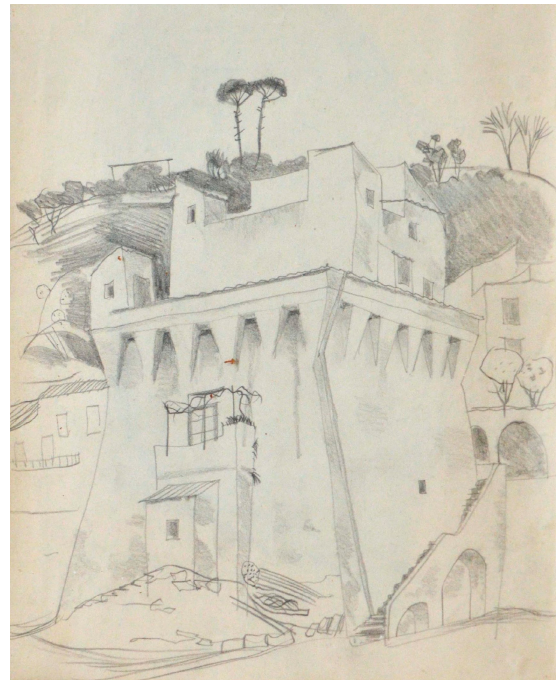
Figure 3. Richard Dölker (1896–1955), Tower di Vietri sul Mare, Pencil Drawing; Coll. Raccolta Arti